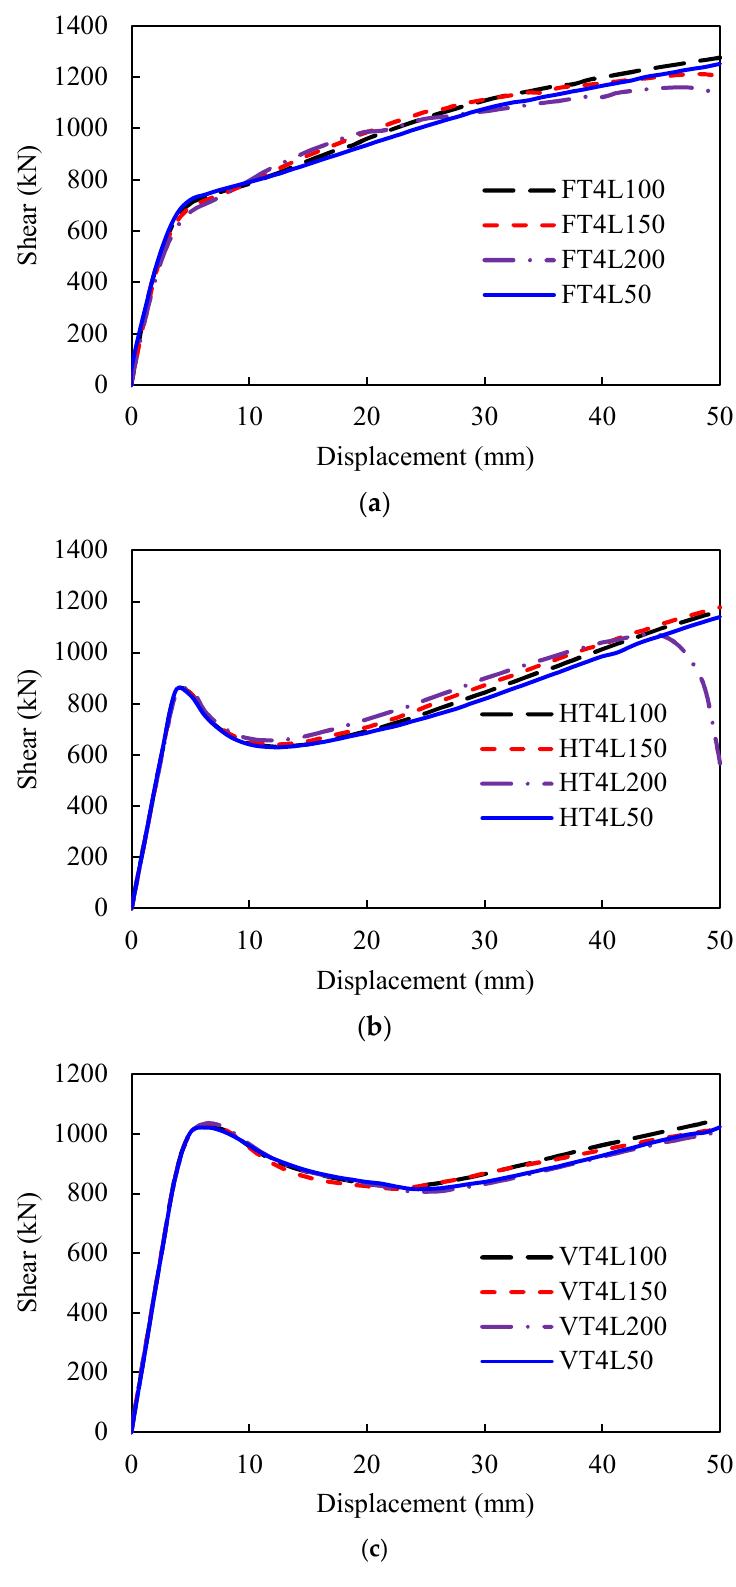
Figure 12. Effect of vertical load on the SPSWs with a thickness of 4 mm and a ( a ) flat, ( b ) horizontal corrugated, and ( c ) vertical corrugated plates.